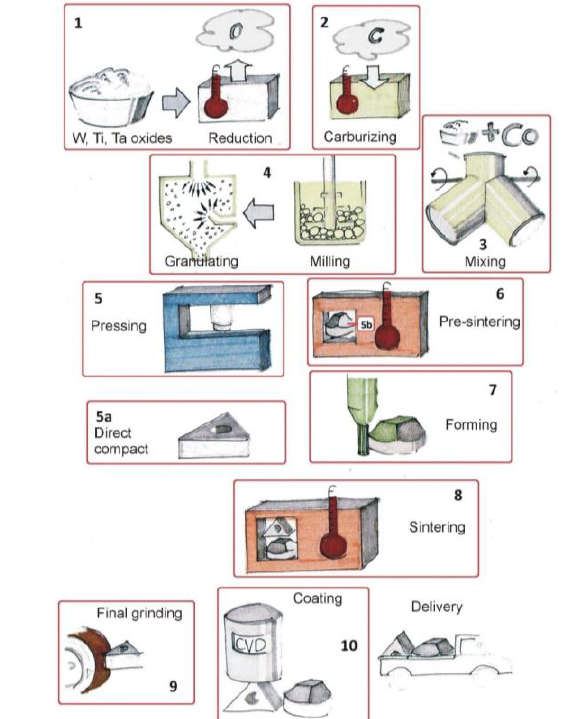
Figure 1. Flowchart illustrating the production of WC-Co cutting tool